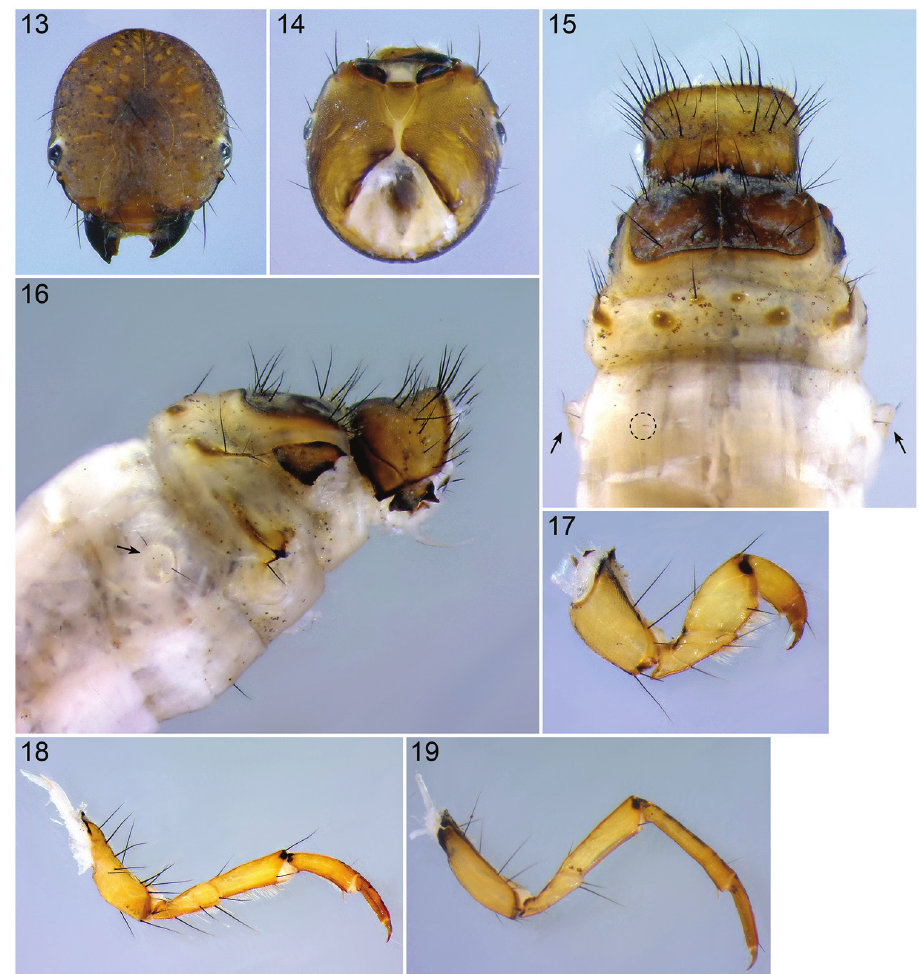
Figures 13–19. Lepidostoma scotti , 5 th instar larva . 13 Head, dorsal view, 40× 14 Head, ventral view, 50× 15 Pro-, Meso- & Metanotum and abdominal segment I, dorsal view (arrows indicate abdominal segment I lateral protuberances, dashed circle indicate abdominal segment I sa ), 25× 16 Thorax and abdominal 2 segment I, lateral view (arrow indicates abdominal segment I lateral protuberance), 23× 17 Left front leg, anterior face, 50× 18 Left middle leg, anterior face, 40× 19 Left hind leg, anterior face,